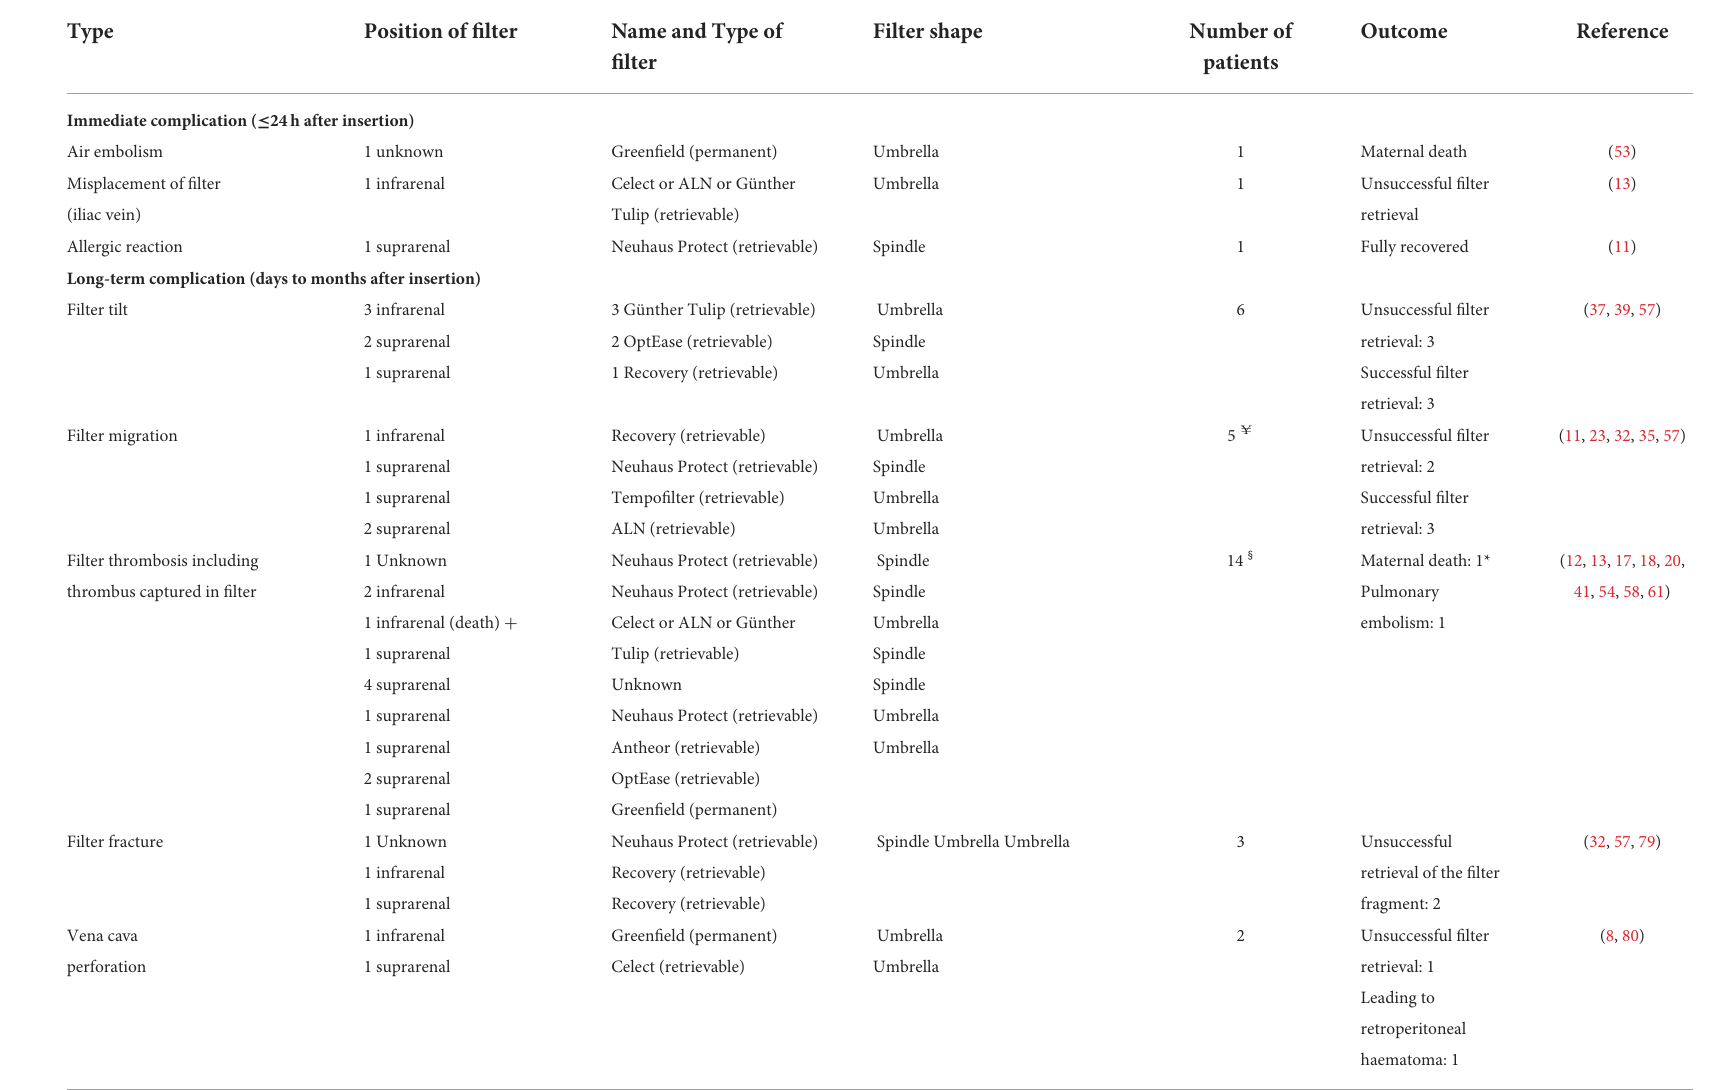
TABLE 2 Immediate and long-term complications of inferior vena cava filters inserted during